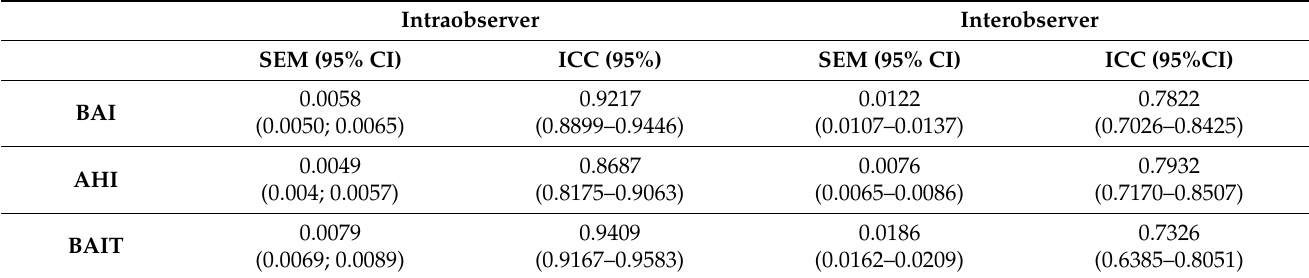
Table A3. Intraobserver and interobserver reliability test of the anthropometric measurement.